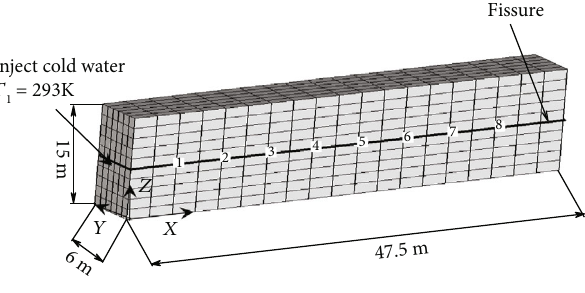
Figure 3: Numerical simulation